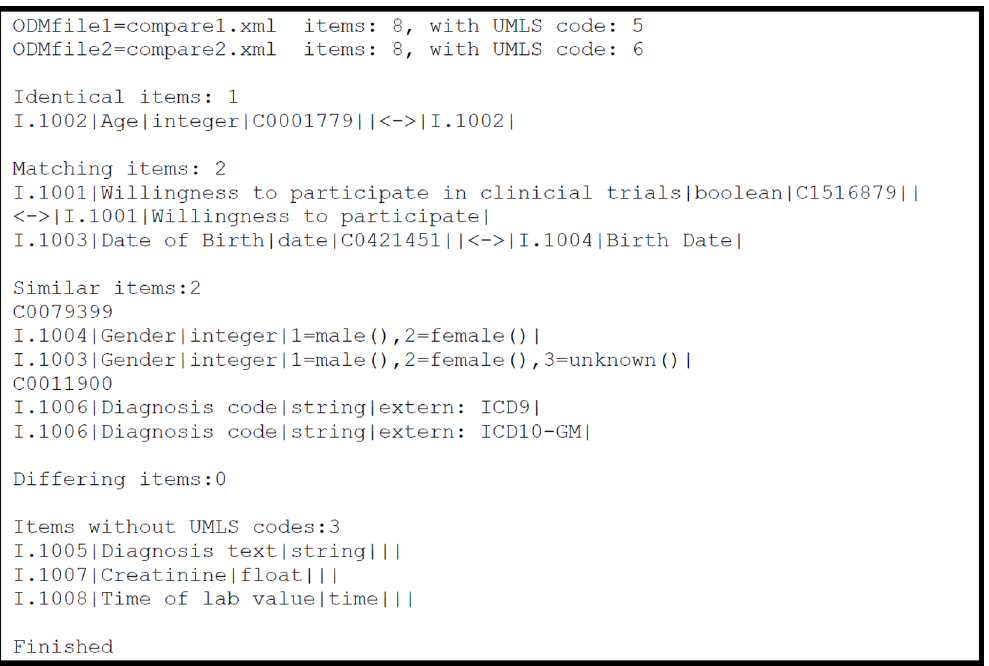
Figure 3. Output of form comparison tool (compareODM). Forms represented by compare1.xml and compare2.xml have 1 identical item, 2 matching items and 2 similar items. 3 items in ODMfile1 do not have an UMLS code assigned; therefore an automatic comparison is not possible. Items are presented with name, value domain and concept code.